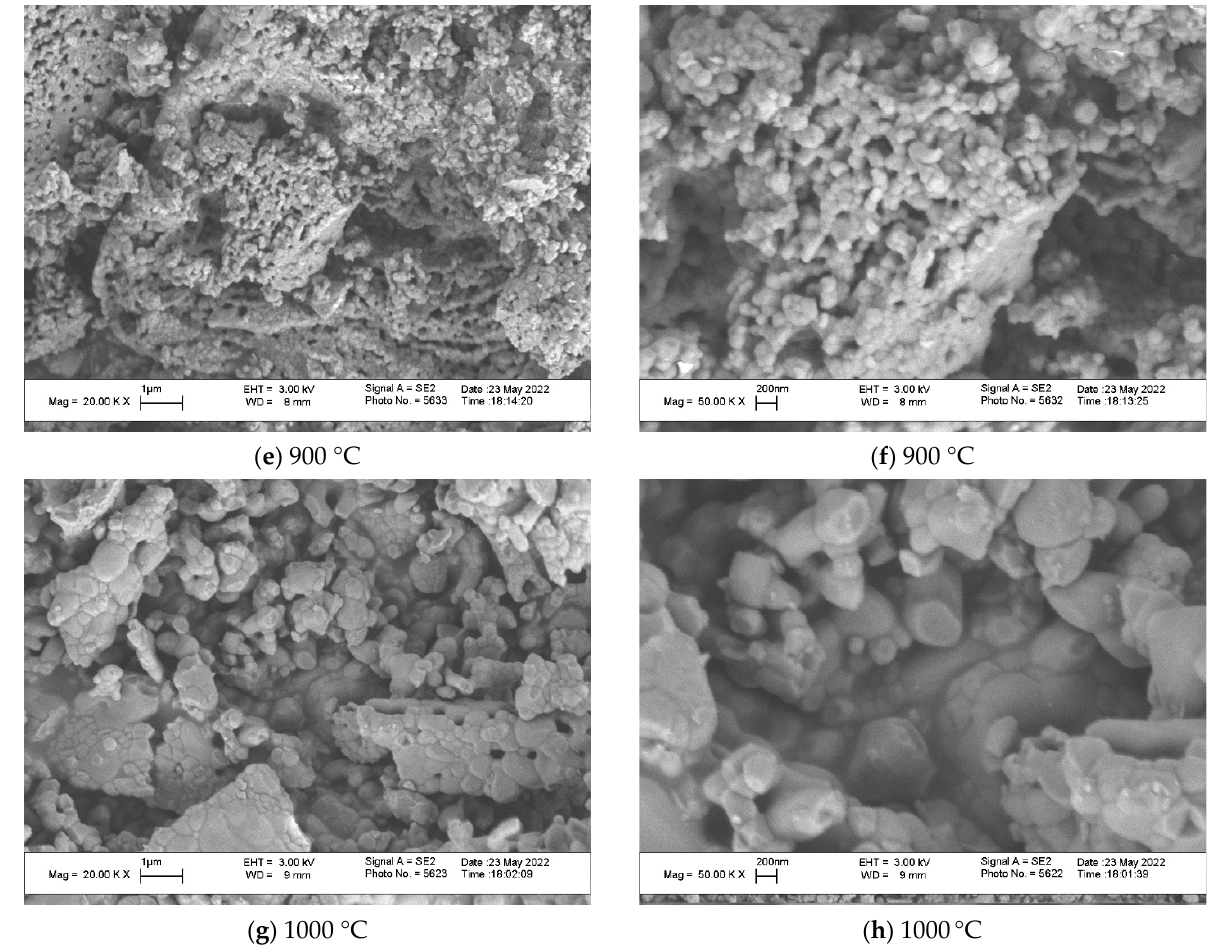
Figure 9. Micrographs of powders prepared from the mixture of fish scales using high-speed grinding and vibration sieving after heat treatment at 400 °C ( a , b ), 700 °C ( c , d ), 800 °C ( e , f ) 900 °C ( g , h ), and 1000 °C ( i , j ) using magnifications of ×20,000 ( a , c , e , g , i ) and ×50,000 ( b , d , f , h , j ).